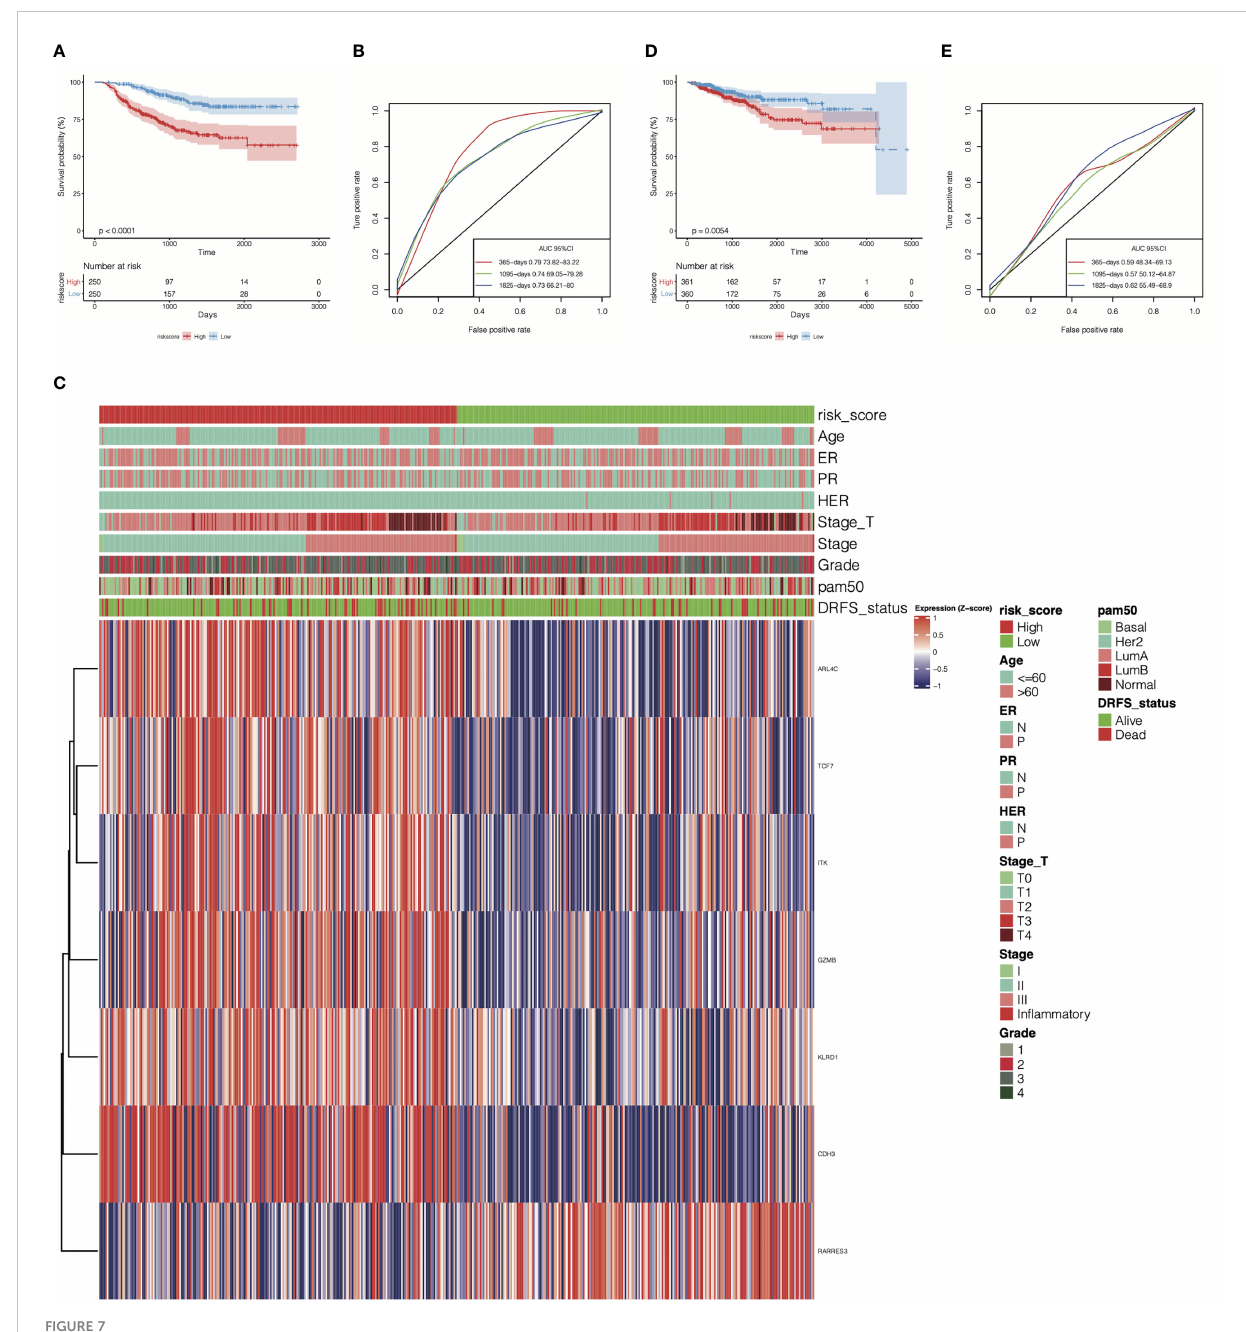
FIGURE 7 Prognostic energy ef fi ciency analysis of cr-TILCD8TSig scoring models. (A) Kaplan-Meier analysis of the cr-TILCD8TSig subgroups in GSE25066 cohort. (B) ROC analysis of cr-TILCD8TSig on DRFS at 1-,3-, and 5-years follow up in GSE25066 cohort. (C) The cr-TILCD8TSig grouping in the GSE25066 cohort. Age, ER, PR, HER, stage_T, stage, grade, pam50 and survival status are shown as patient annotations. (D) Kaplan-Meier analysis of the cr- TILCD8TSig subgroups in TCGA-BRCA cohort. (E) ROC analysis of cr-TILCD8TSig on DRFS at 1-,3-, and 5-years follow up in TCGA-BRCA